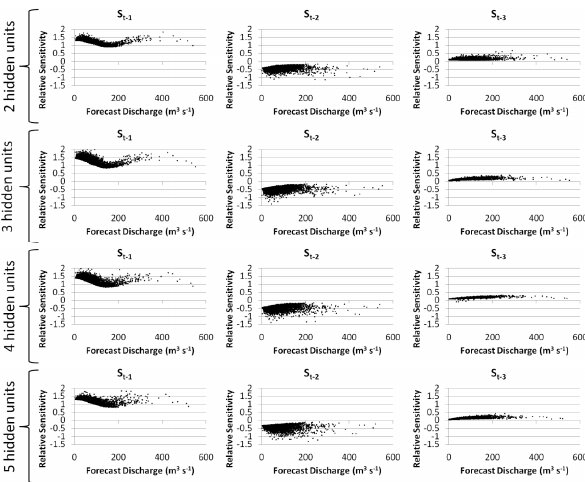
Fig. 11. Global–local relative sensitivity plots for all candidate models in Scenario A: cross-validation